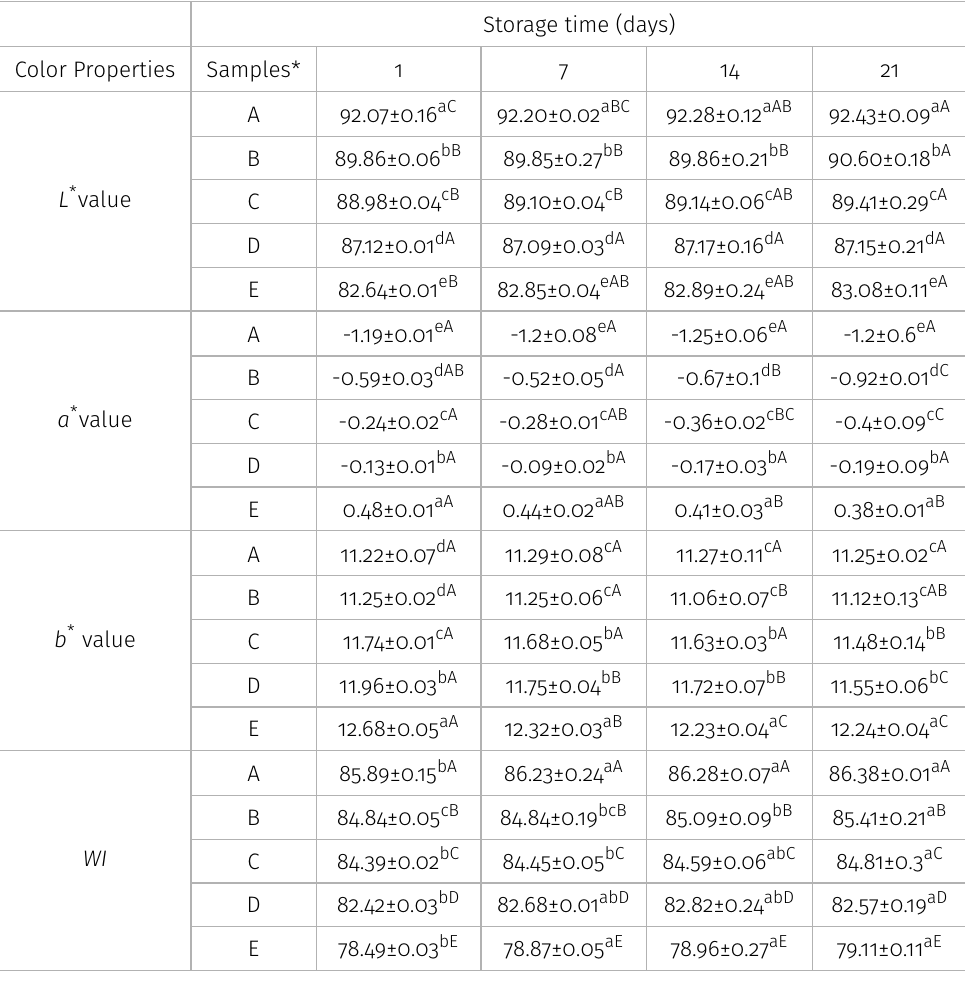
Table III. Color properties of yoghurt-like product produced with cow milk and hazelnut beverage during storage at 4